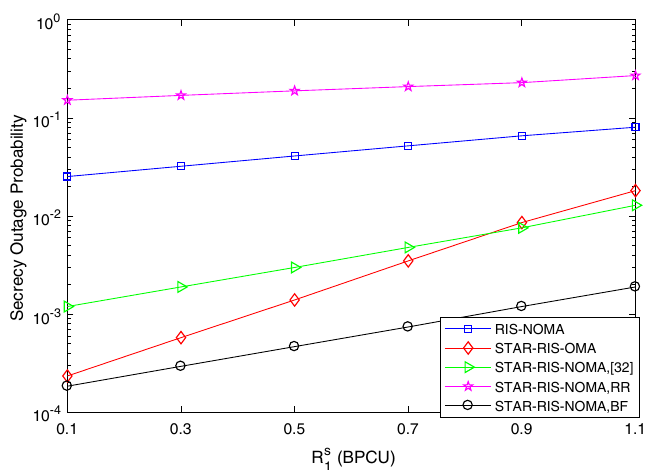
Fig. 7 The SOP versus the secrecy rate requirement of the cell-edge user. When the transmission power is constant, the influence of different secrecy rate requirement of user U 1 on the SOP